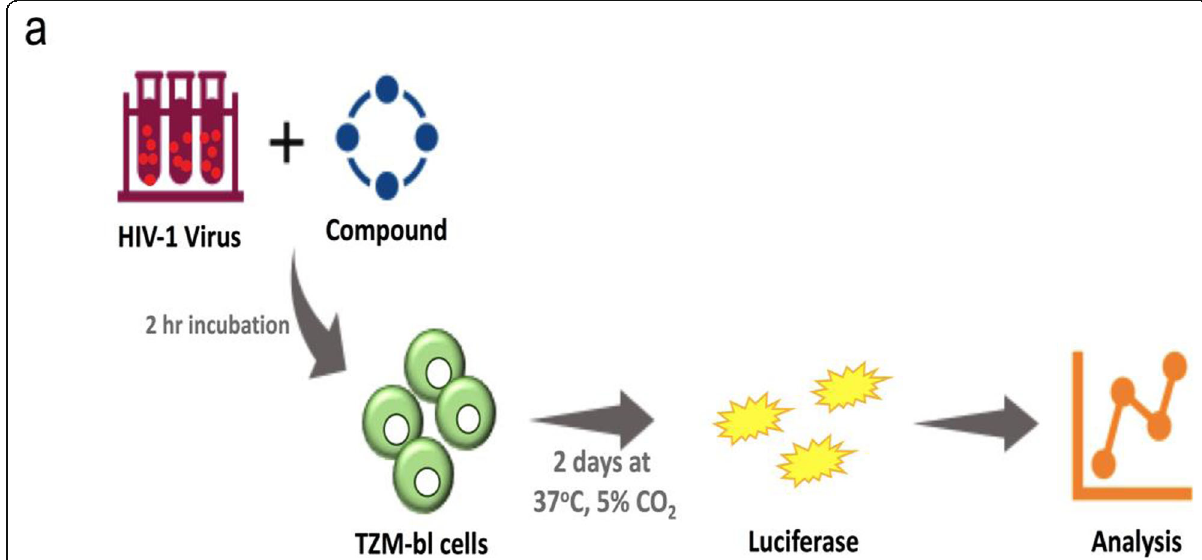
Fig. 11 Diagrammatic representation of the